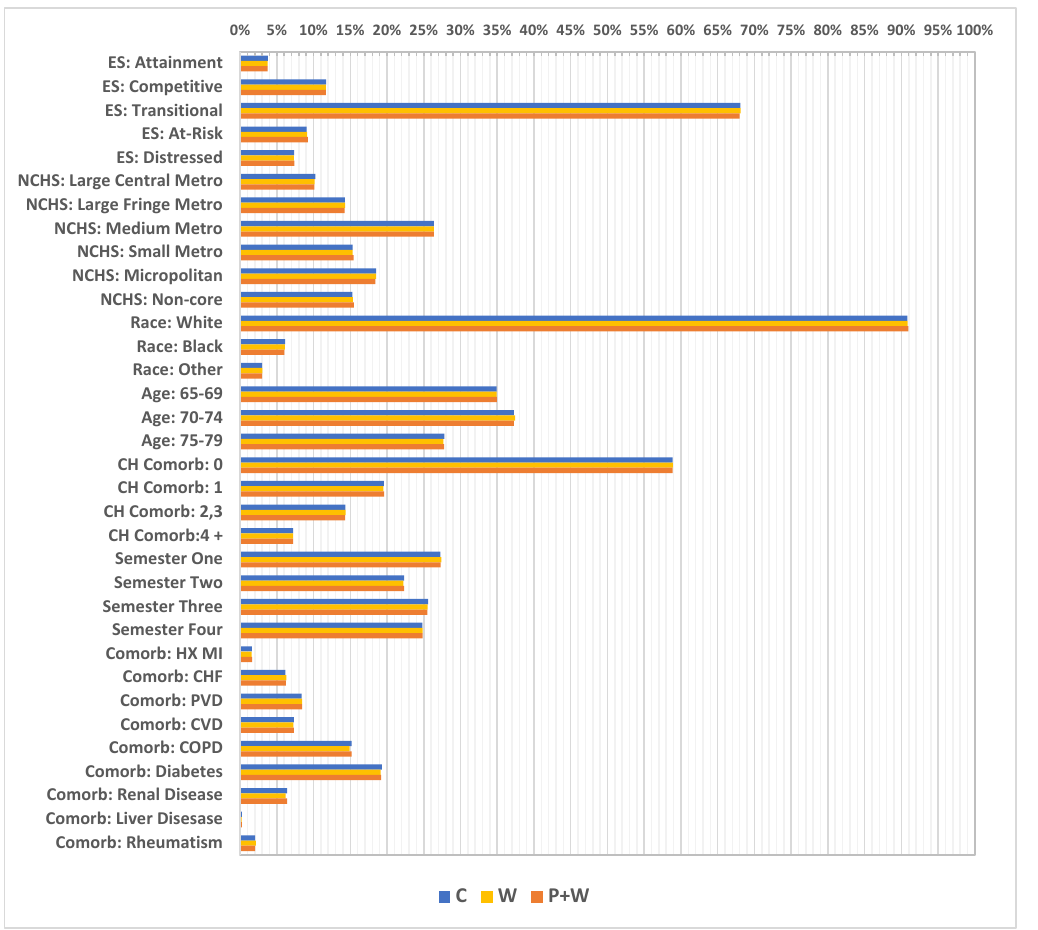
Figure 4. Weighted covariate distributions (after weighting, the sample rates between subgroups became similar). ES—economic status; NCHS—National Center for Health Statistics; Metro—met- ropolitan; CH Comorb—Charlson comorbidity score; HX MI—history of myocardial infraction; CHF—chronic heart failure; PVD—peripheral vascular disease; CVD—cardiovascular disease; COPD—chronic obstructive pulmonary disease.